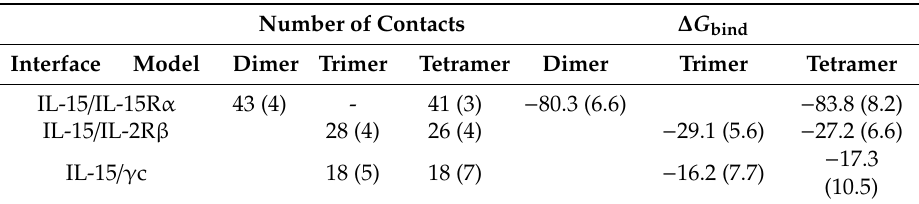
Table 1. Number of contacts and MM / GBSA binding free energies (kcal / mol) for the various interfaces in the three multimeric (dimer, trimer and tetramer) forms of IL-15. The number in parentheses corresponds to the standard